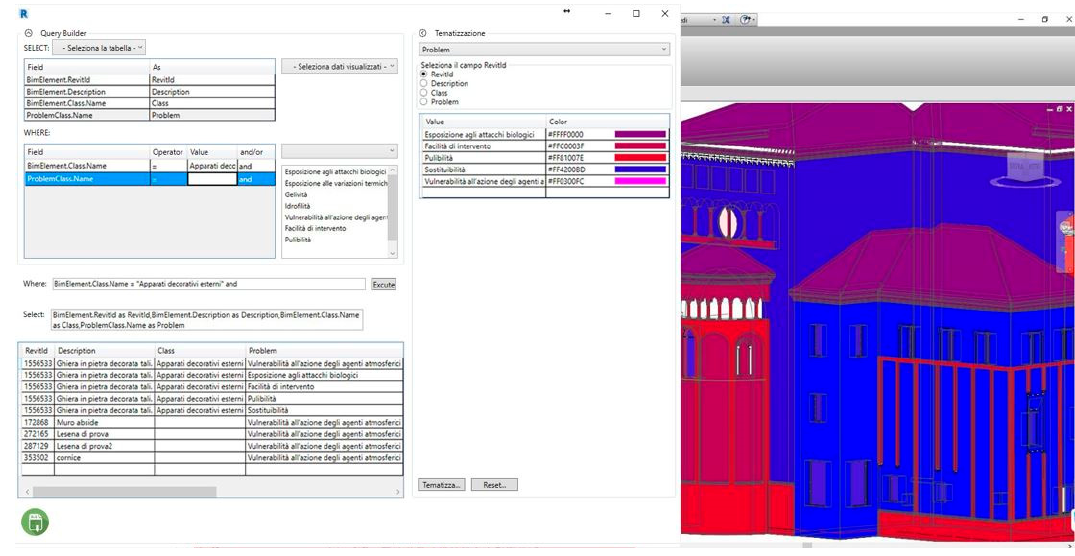
Figure 7. Graphical query builder and model texturized according to the query